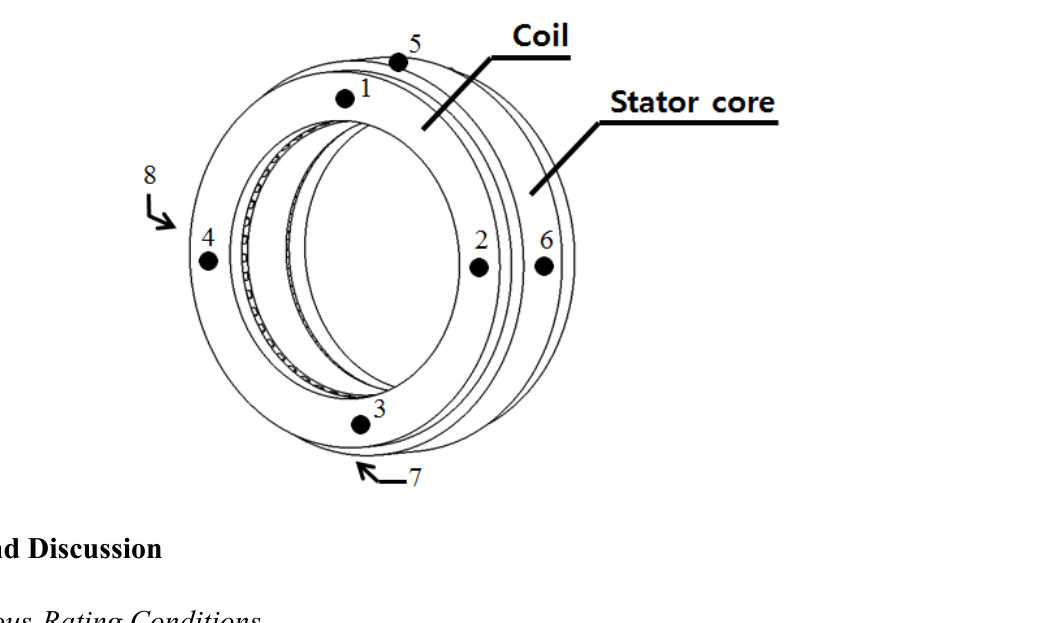
Figure 4. Mounting positions of